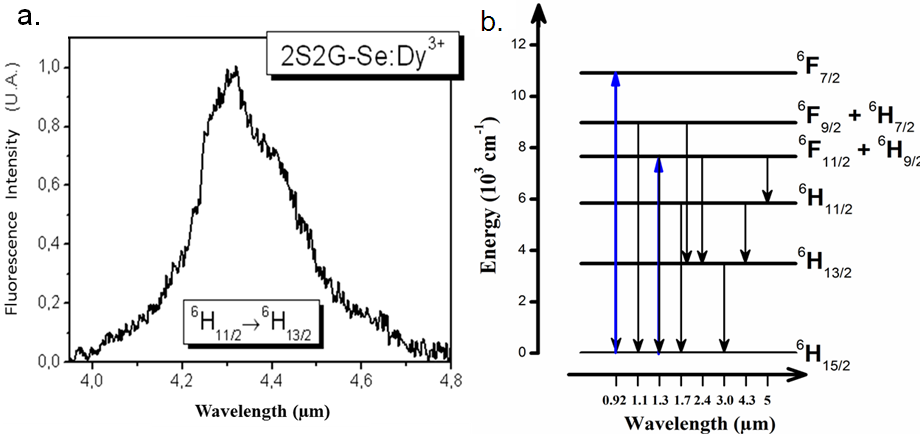
Ge Sb Se bulk 5 25 10 60 Ge Sb 5 25